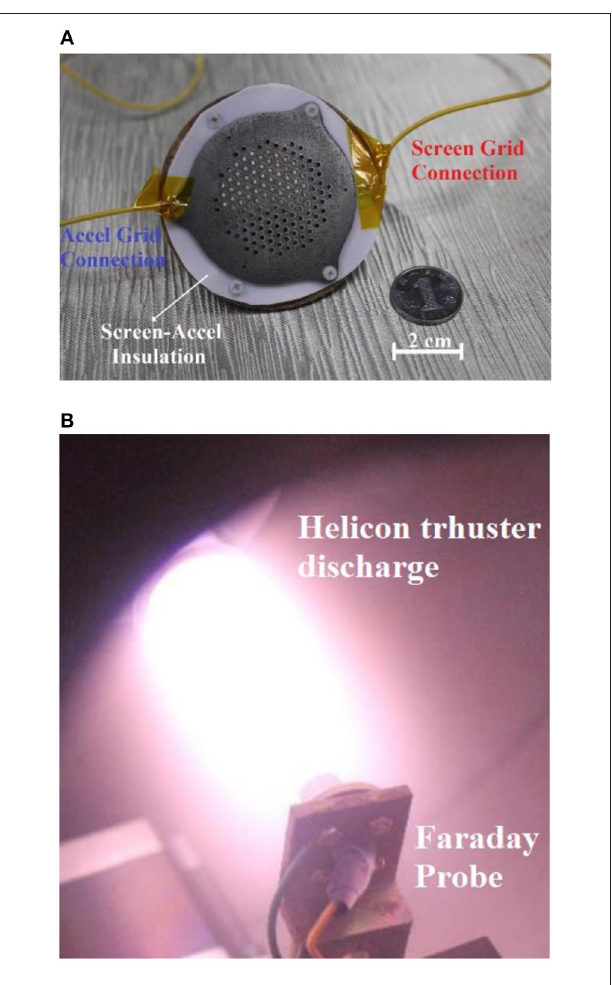
FIGURE 12 | 3D printed molybdenum extraction system assembly (A) before installation on the thruster and (B) during operation.